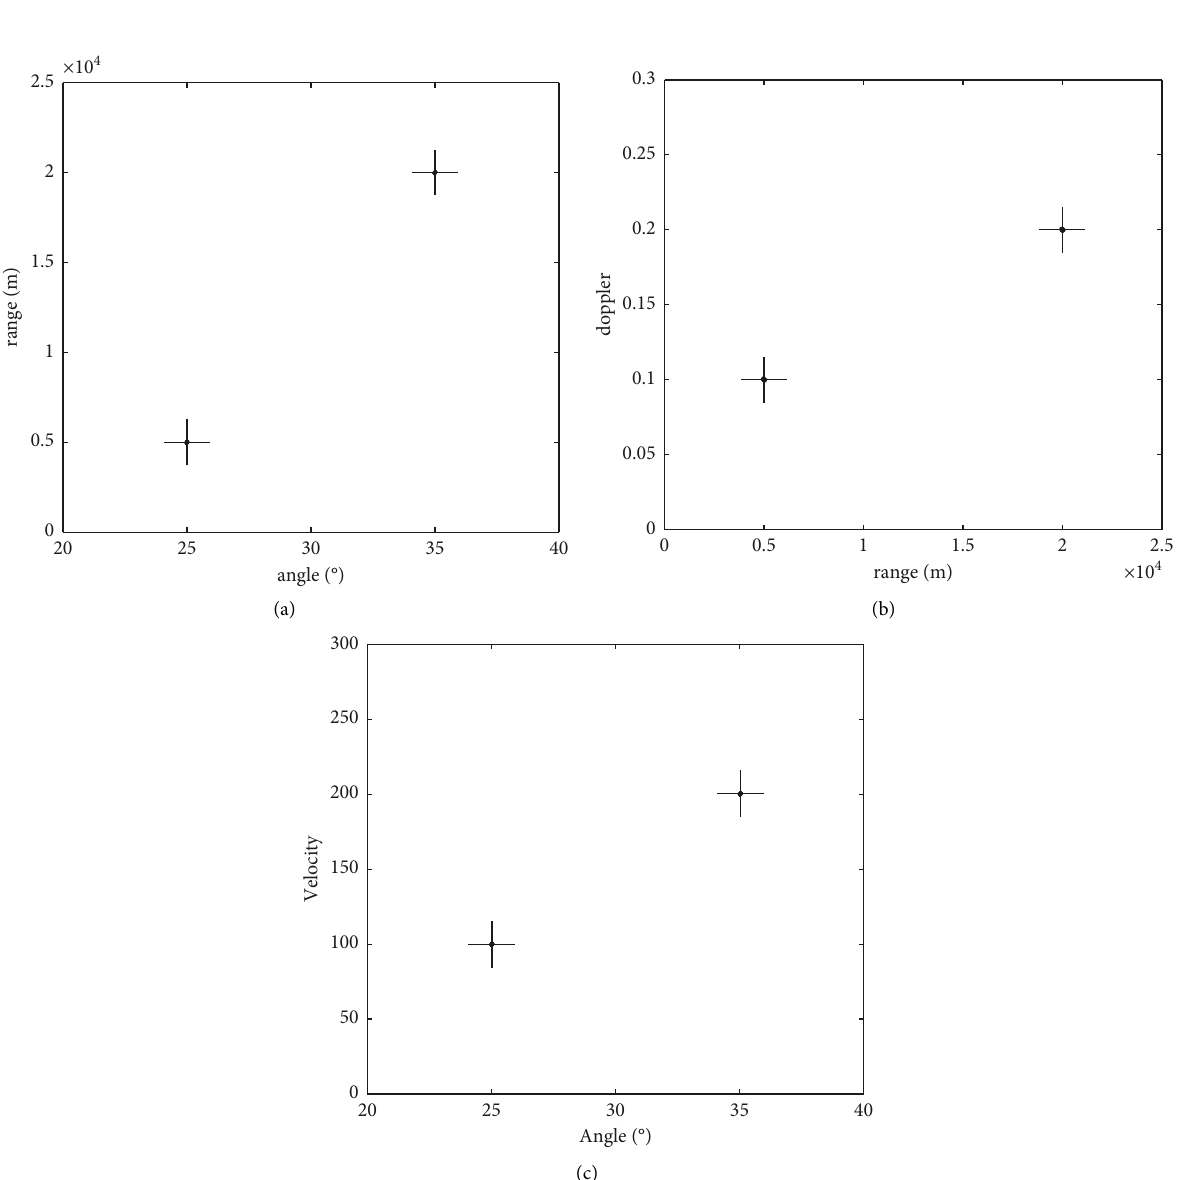
Figure 2: Scatter estimation results of the proposed algorithm. (a) The angle and range estimation result, (b) the range and velocity estimation result, and (c) the angle and velocity estimation